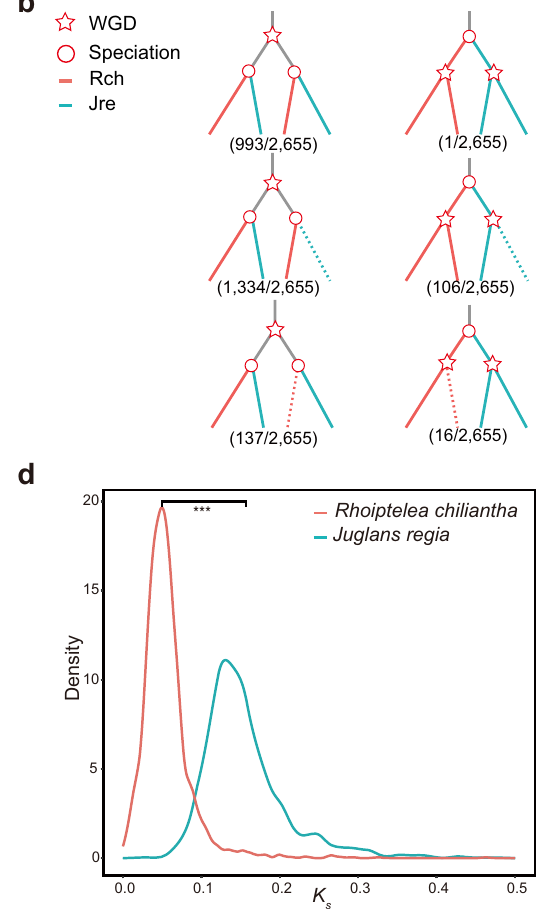
Fig. 3| Rhoipteleachiliantha sharesthejuglandoidwhole-genomeduplication (WGD)withtherestJuglandaceaespecies,butexhibitsmuchslowerevolution following the polyploidization event. a Dot plot showing homologous chro- mosomesof R.chiliantha and J.regia .Syntenicblocksare plottedwith theircolors indicatingtheirmedian K s values.Eachpairofhomoeologouschromosomesinone species shows collinear relationships with one homologous pair in another. The dot colors distinguish between orthologous (yellow: smaller K s ) and paralogous (green: larger K s ) relationships, pointing to the WGD shared by the two species. b Phylogenies from the three types of gene families (see main text). The phylo- genetictreesatthetop,middle,andbottomarefromgenefamiliesoftype1,2and 3, respectively. For the scores shown in parentheses, the denominator is the total number of gene trees with bootstrap values ≥ 80 (2655 trees) and the numerator represents the number of gene trees displaying the respective topology with